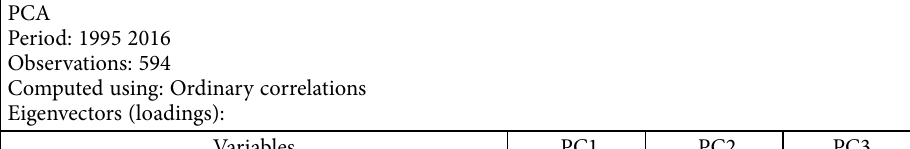
Table 5. Eigenvectors of the principal components (source: own computations using EViews 10) PCA Period: 1995